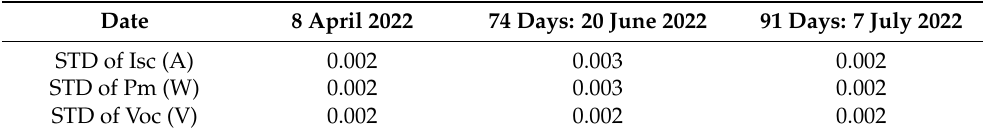
Table 7. Standard deviation (STD) of Isc, Pm, and Voc for Q2 sample after coating with PA Si-QDs and encapsulation.